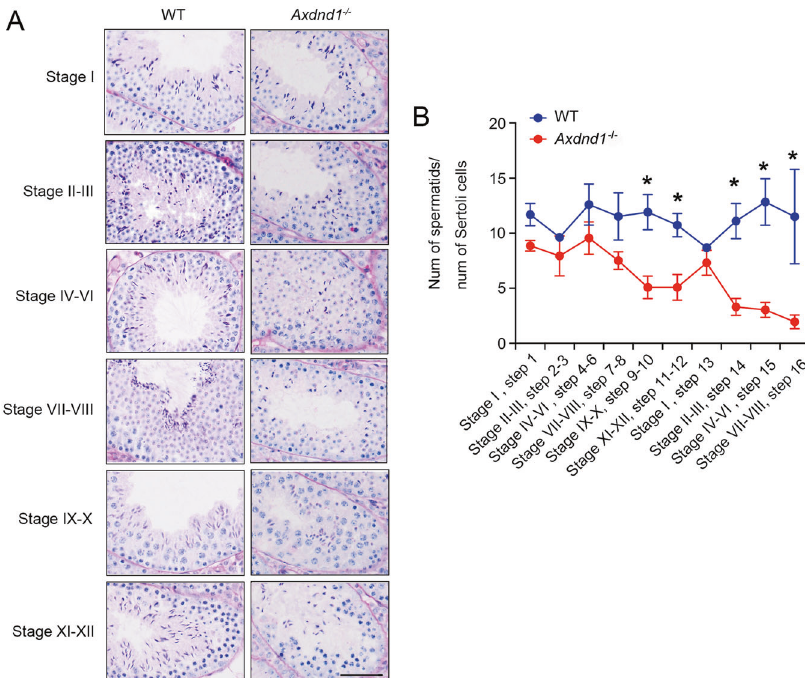
Fig. 4 Axdnd1 − / − mice display progressive germ cell loss during spermiogenesis. A Representative images of seminiferous tubules at various stages from adult WT and Axdnd1 − / − male mice are shown. Disorganized germ cells and reduced late spermatids were observed in Axdnd1 − / − male mice. Scale bar: 100 µm. B Statistical analysis of the ratio of spermatids to the number of Sertoli cells during spermiogenesis (from steps 1 – 16). Signi fi cant loss of step 9 – 16 spermatids occurred in Axdnd1 − / − male mice during the later-half phase of spermiogenesis. Data are presented as Mean ± SEM, n = 3. * P < 0.05 by Student ’ s t